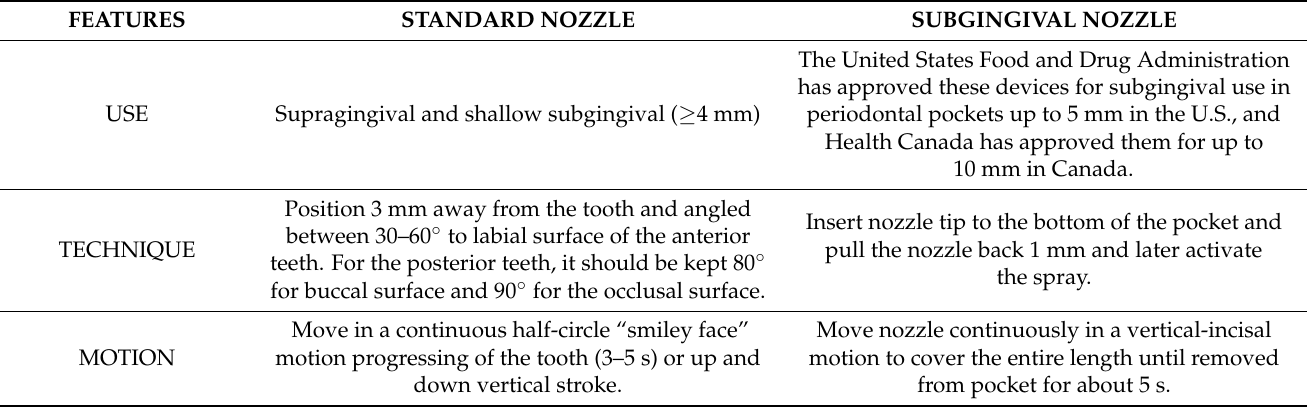
Table 1. Technical tips of air-polishing device with air abrasive powder